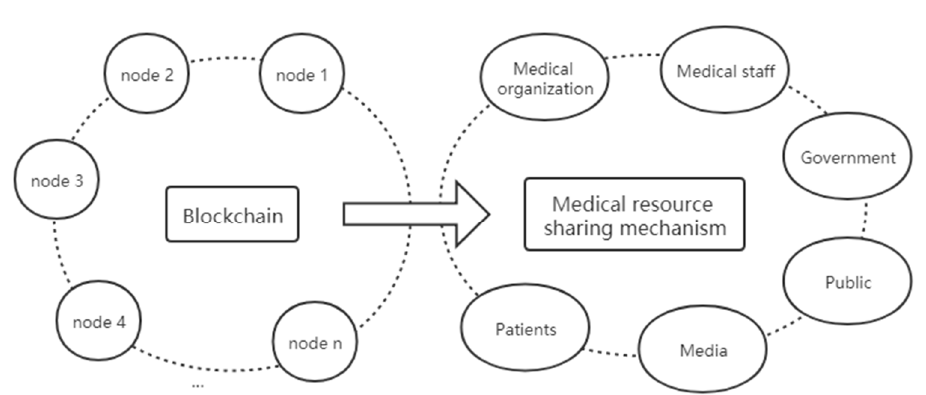
Figure 4. Application principal coupling analysis.